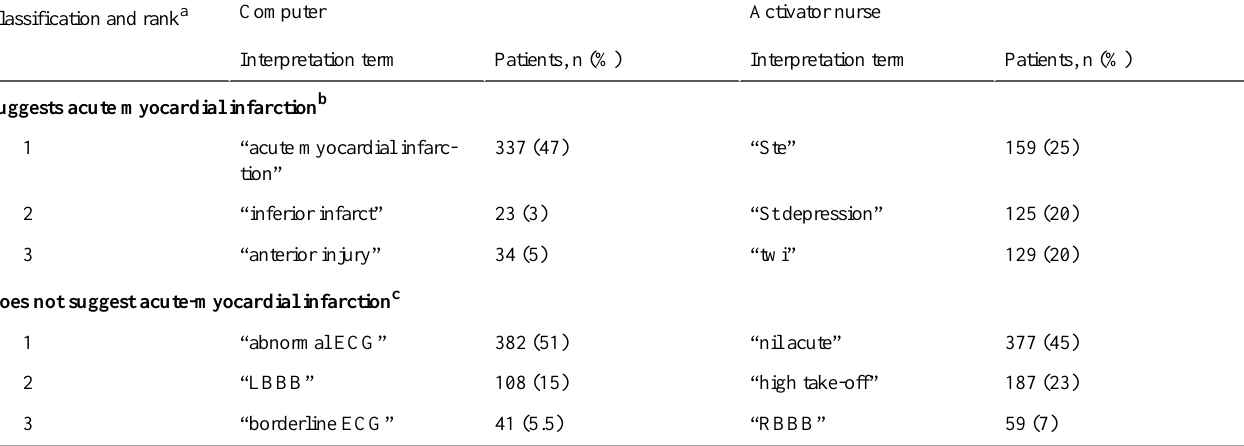
Table 3. Frequently used terms by computer and activator nurses for suggesting or not suggesting acute myocardial